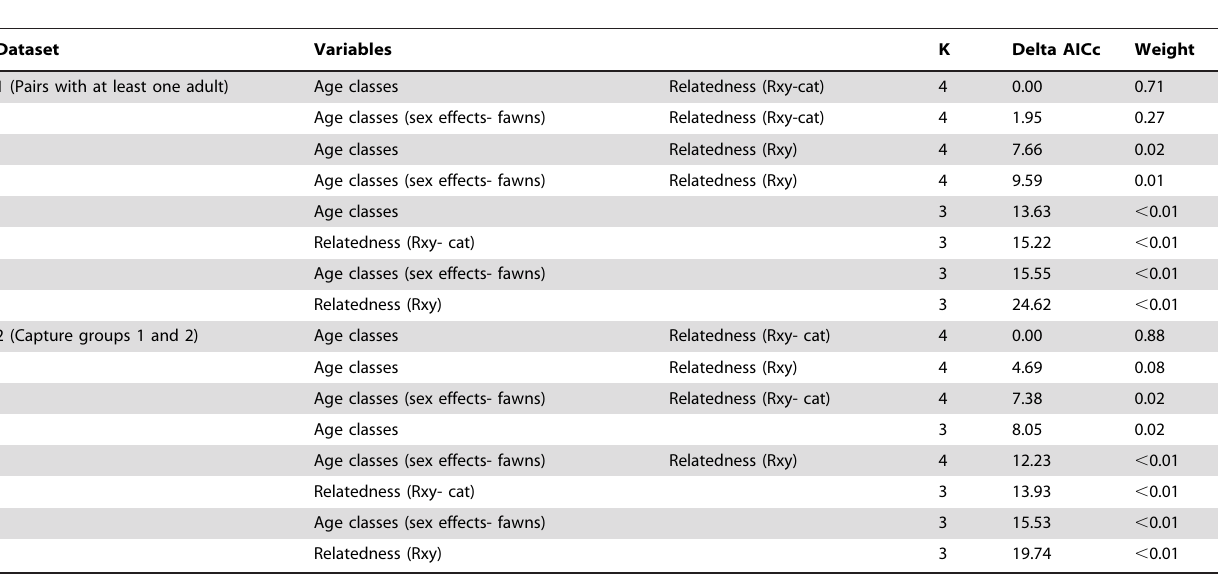
Table 1. Results of AIC model selection procedure to determine the best models predicting white-tailed deer spatial overlap in